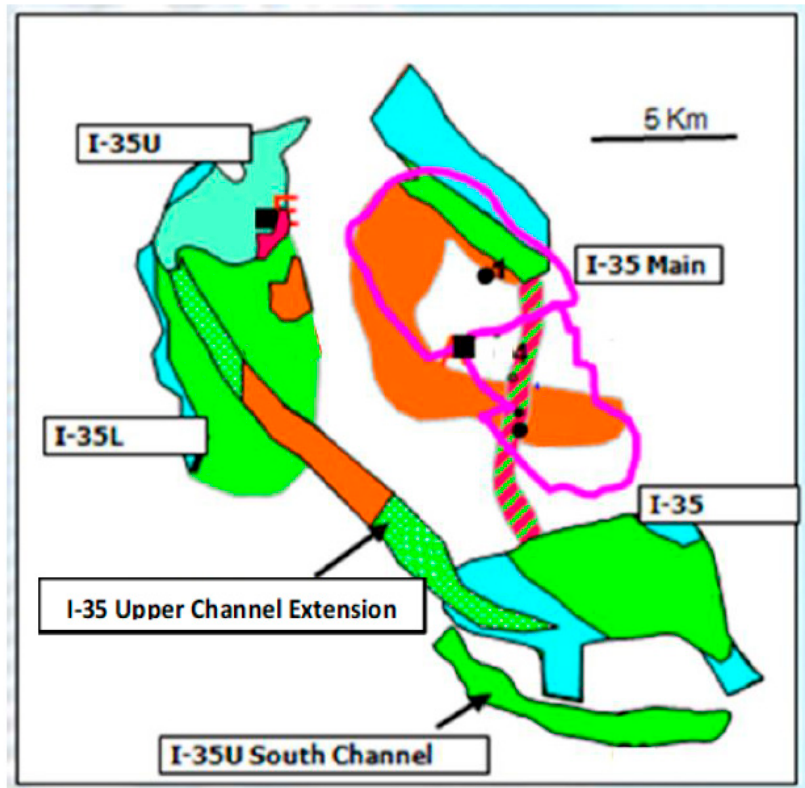
Figure 2. Schematic map of main reservoirs in A Field .